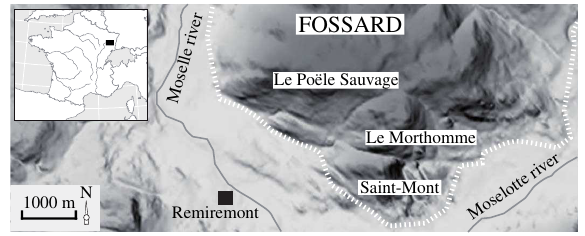
Figure 5. Map of tested area.